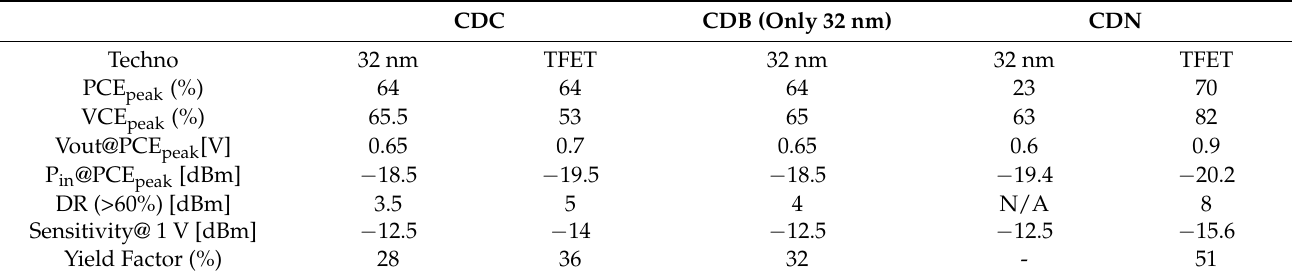
Table 2. FOMs and performance